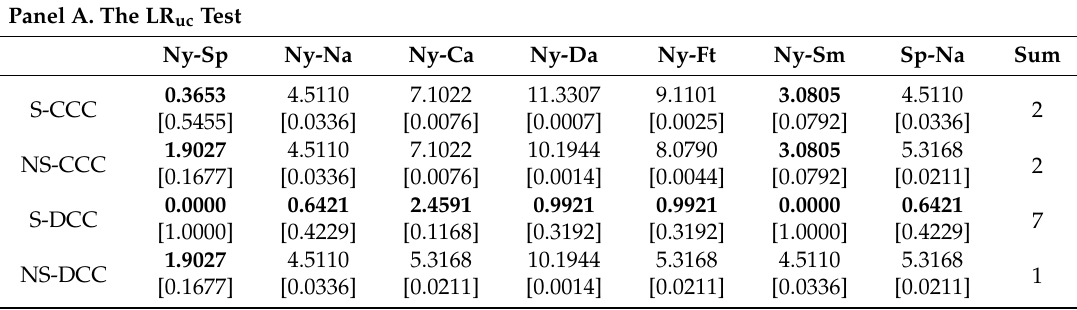
Table 6. The out-of-sample VaR forecasts performance based on alternative accuracy